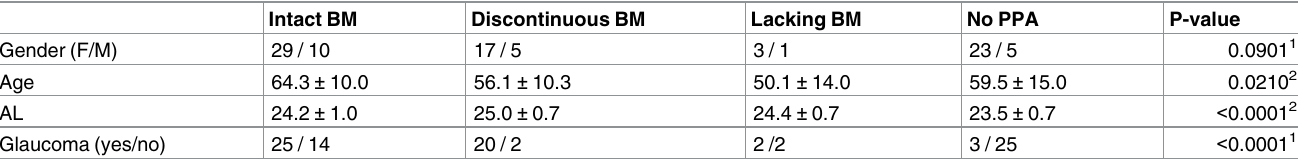
Table 4. Clinical characteristics by subgroup categorized based on presenceor absence of beta zone and gamma zone